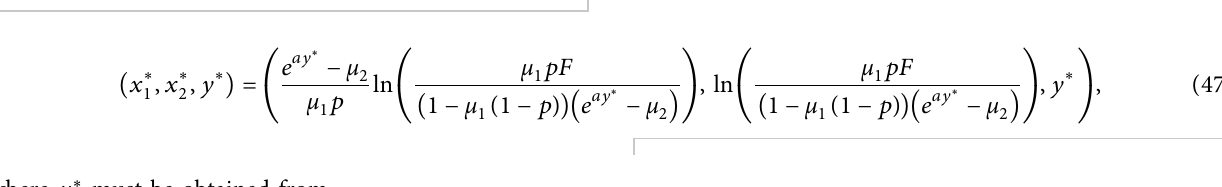
, x ∗ and y ∗ as functions of skill parameter a . Parameter values: ( μ 1 2